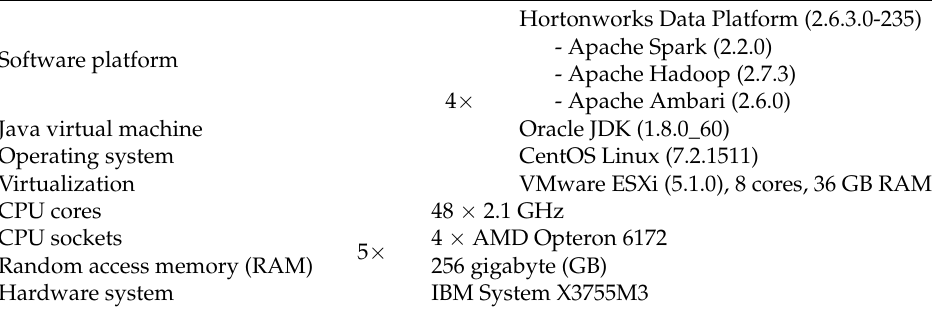
Table 2. Software and hardware configuration of the test system.